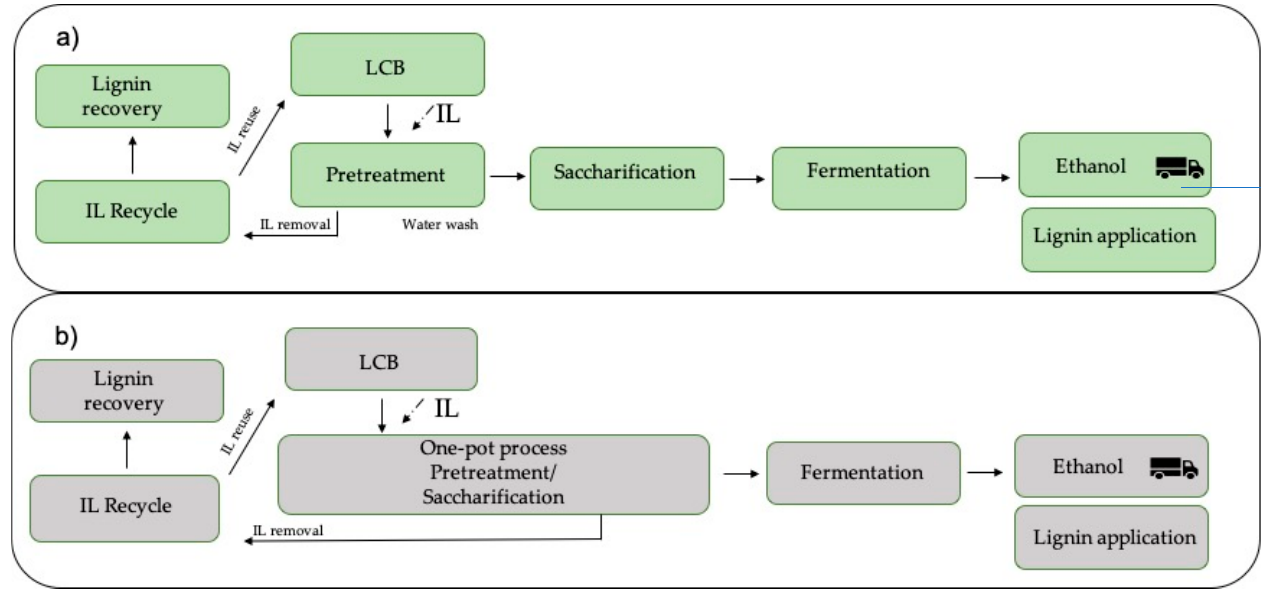
Figure 2. Block diagram for the production of bioethanol from lignocellulosic material. ( a ) Conven- tional pretreatment and saccharification in separated steps; ( b ) one-pot integrated IL process for biofuel